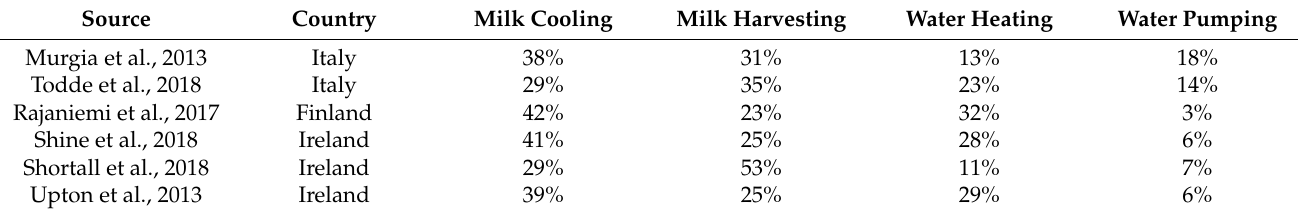
Table 2. Electrical energy breakdown dairy farms EU (based on